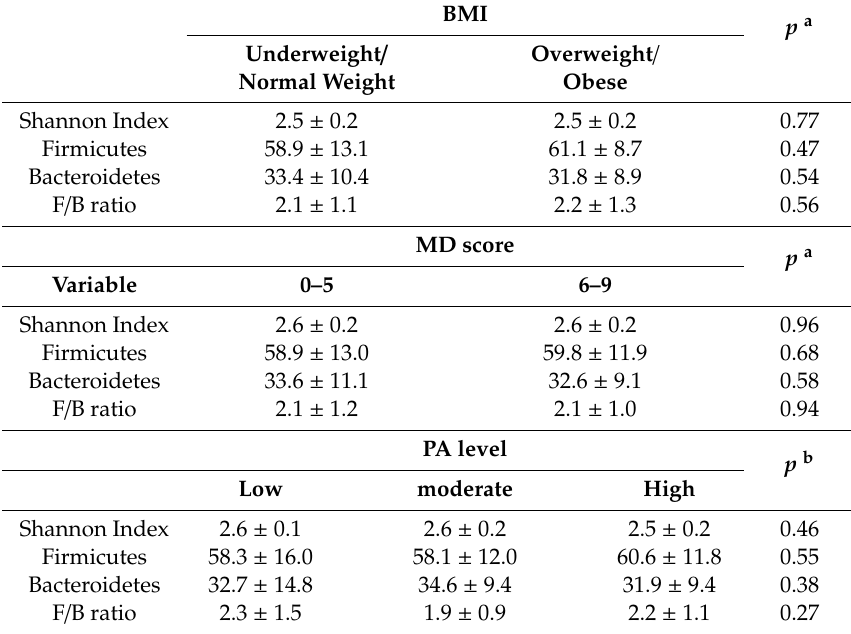
(F / B) ratio of the BMI, MD score, and PA level groups, with corresponding p -values.